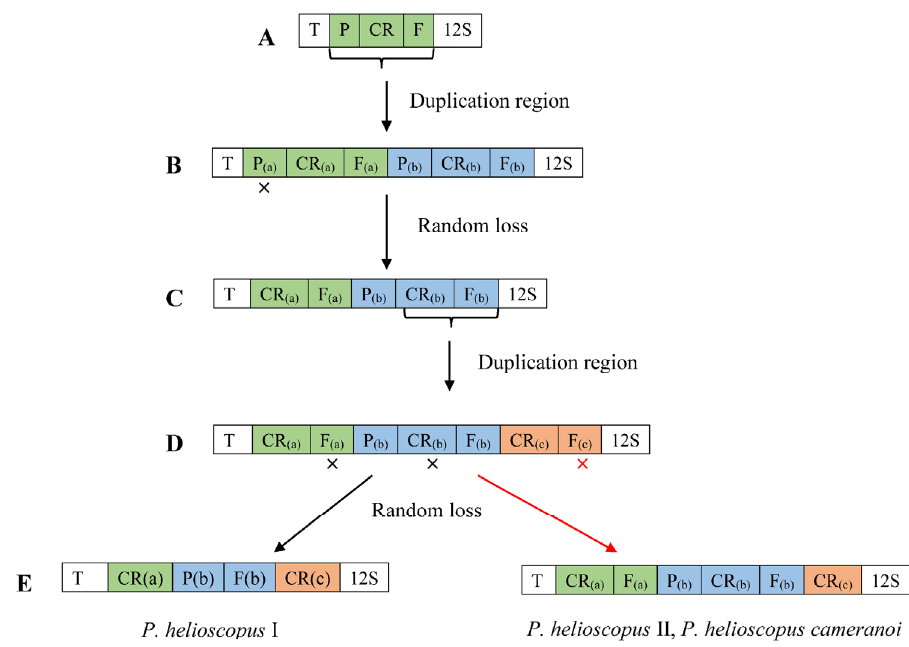
Figure 6. The hypothetical process of gene rearrangement in the model of tandem duplication/random loss: ( A ) the ancestral gene order in vertebrate; ( B ) the tandem duplication of P/CR/F; ( C ) the random loss of P(a); ( D ) the tandem duplication of CR(b)/F(b); ( E ) random loss of F(a) and CR(b), the formation of P. helioscopus varius I arrangement type; random loss of F(c), the formation of P. helioscopus varius II and P. helioscopus cameranoi arrangement type. “x” indicates the random loss of the genes; T, P, F, 12S and CR stand for Threonine, Proline, Phenylalanine, 12S rRNA , control region, respectively.